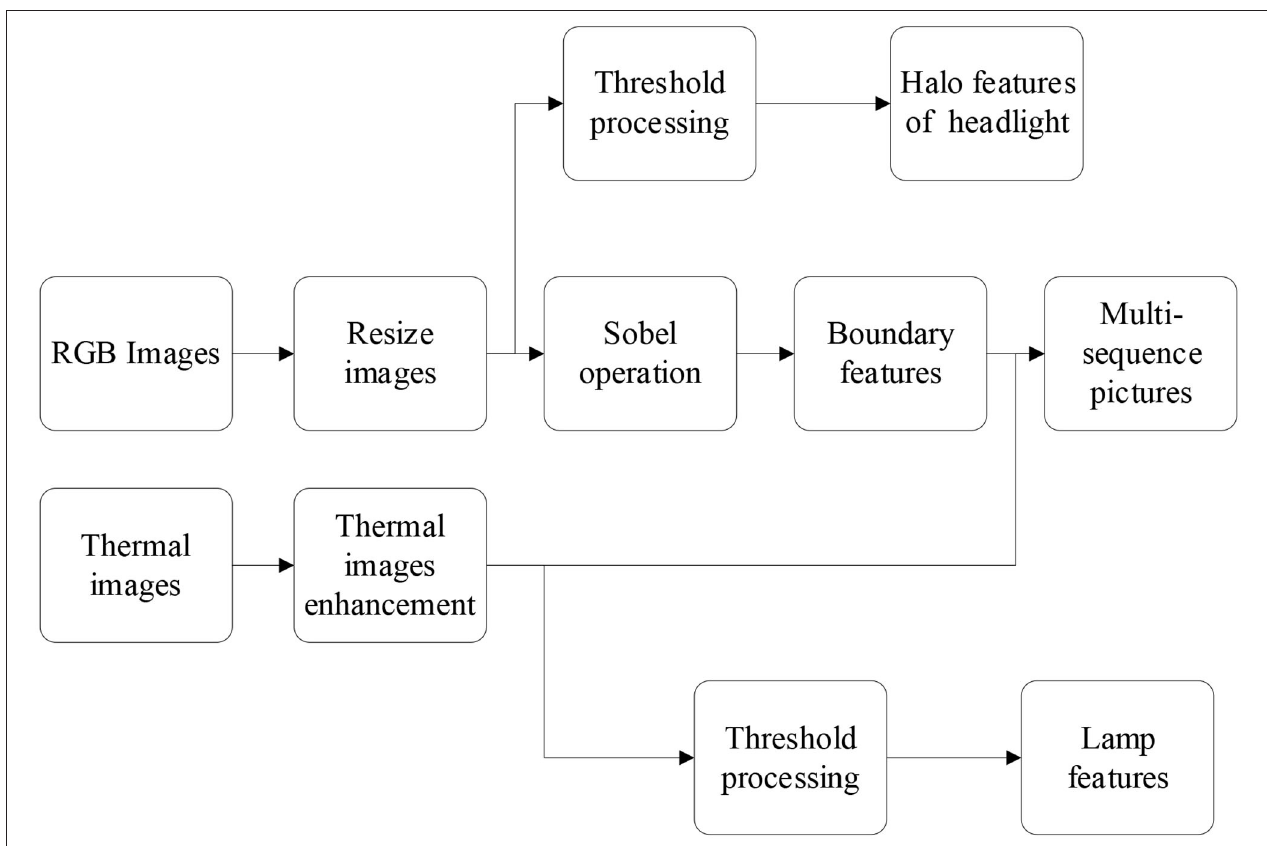
FIGURE 3 | Flowchart of feature fusion for a multi-sequence